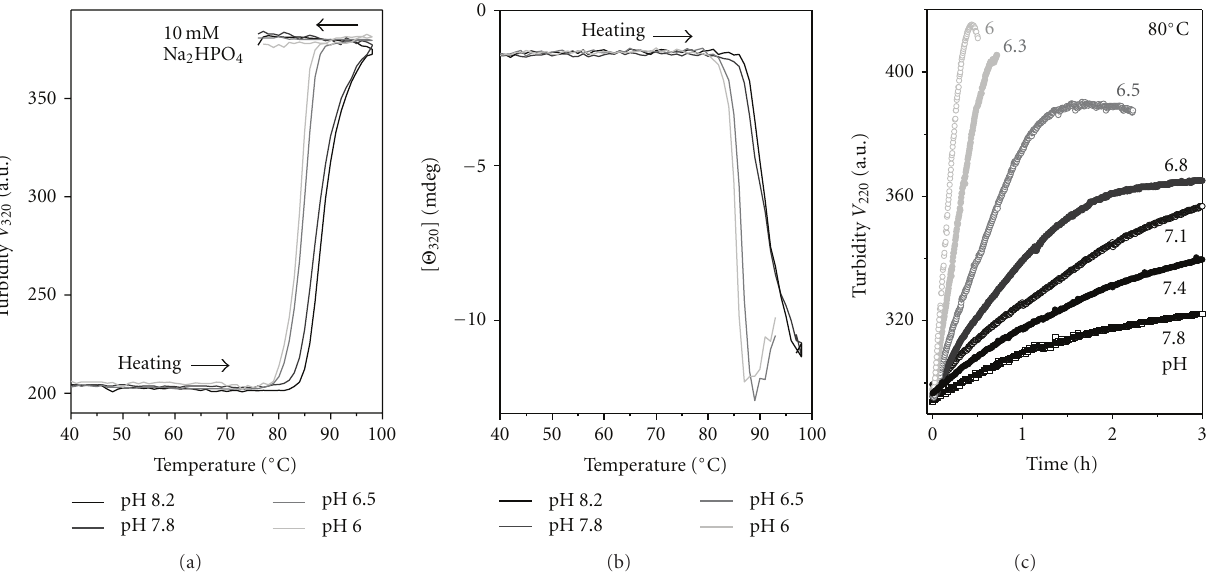
Figure 4: E ff ects of pH on VLDL stability. Thermal denaturation of VLDL in 10mM Na phosphate bu ff er at pH 8.2–6.0 (selected pH values are shown) was analyzed in the melting ((a) and (b)) and kinetic CD experiments (c). In the melting experiments, VLDL solutions were heated at a rate of 11 ◦ C/h. Changes in turbidity (a) and circular dichroism (b) were monitored at 320nm for increase in the particle size upon lipoprotein fusion and coalescence into droplets (a) and lipoprotein rupture and repacking of apolar lipids in droplets (b). In temperature- jump experiments (c), VLDL heat denaturation was triggered at time t = 0 by a rapid increase in temperature from 25 to 80 ◦ C, and the denaturation time course was monitored by turbidity at